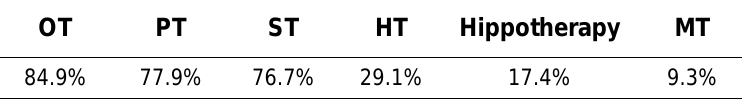
Therapeutic Interventions for Individuals with RS